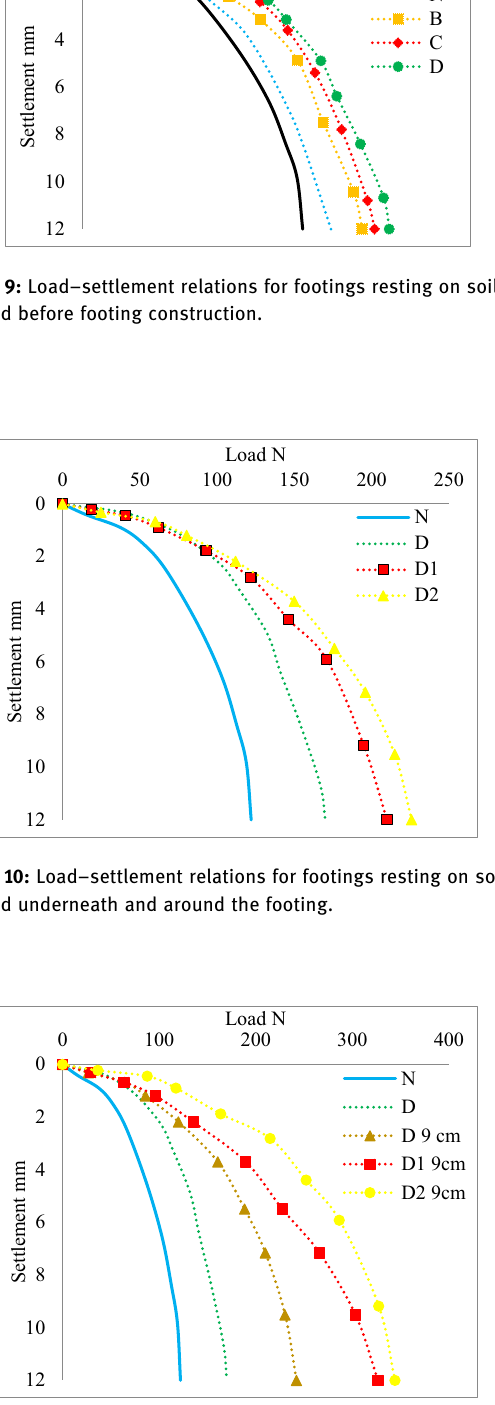
Figure 11: Load – settlement relations of footings resting on soil grouted underneath and around the footing to a depth of 1.5 d ′ 9cm.